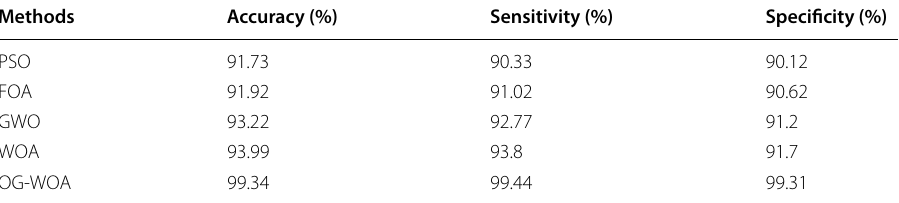
Table 3 Performance analysis of different optimization algorithm for feature selection on UCM